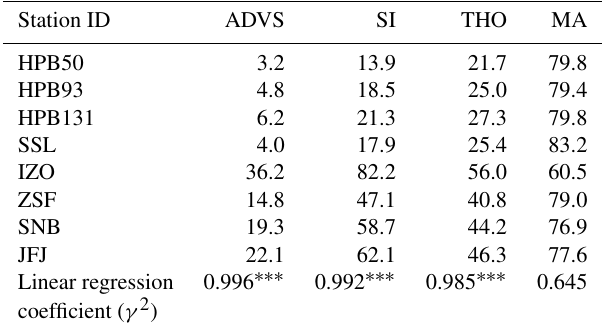
Table 2. Percentage of selected data in all data by different data selection methods. The bottom shows the linear regression coeffi- cients of station (HPB is represented by HPB50; IZO is excluded) altitudes and the percentages of selected data at the significance level of 0.05 ( ∗∗∗